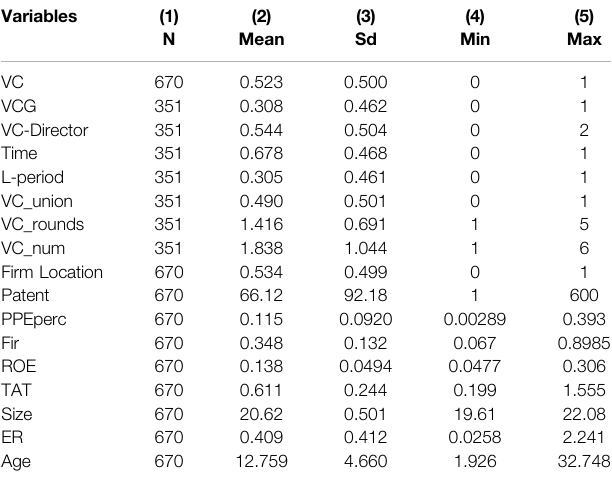
TABLE 2 | Descriptive statistics of variables.